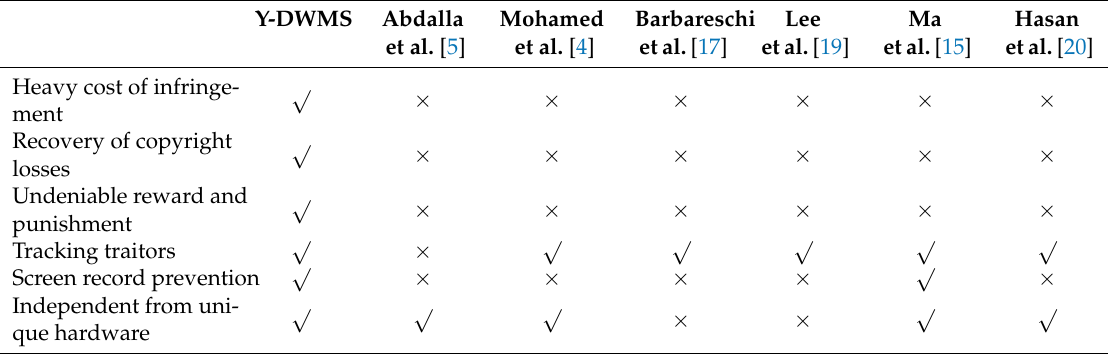
Table 1. Comparison of different schemes and our YODA-based digital watermark management system